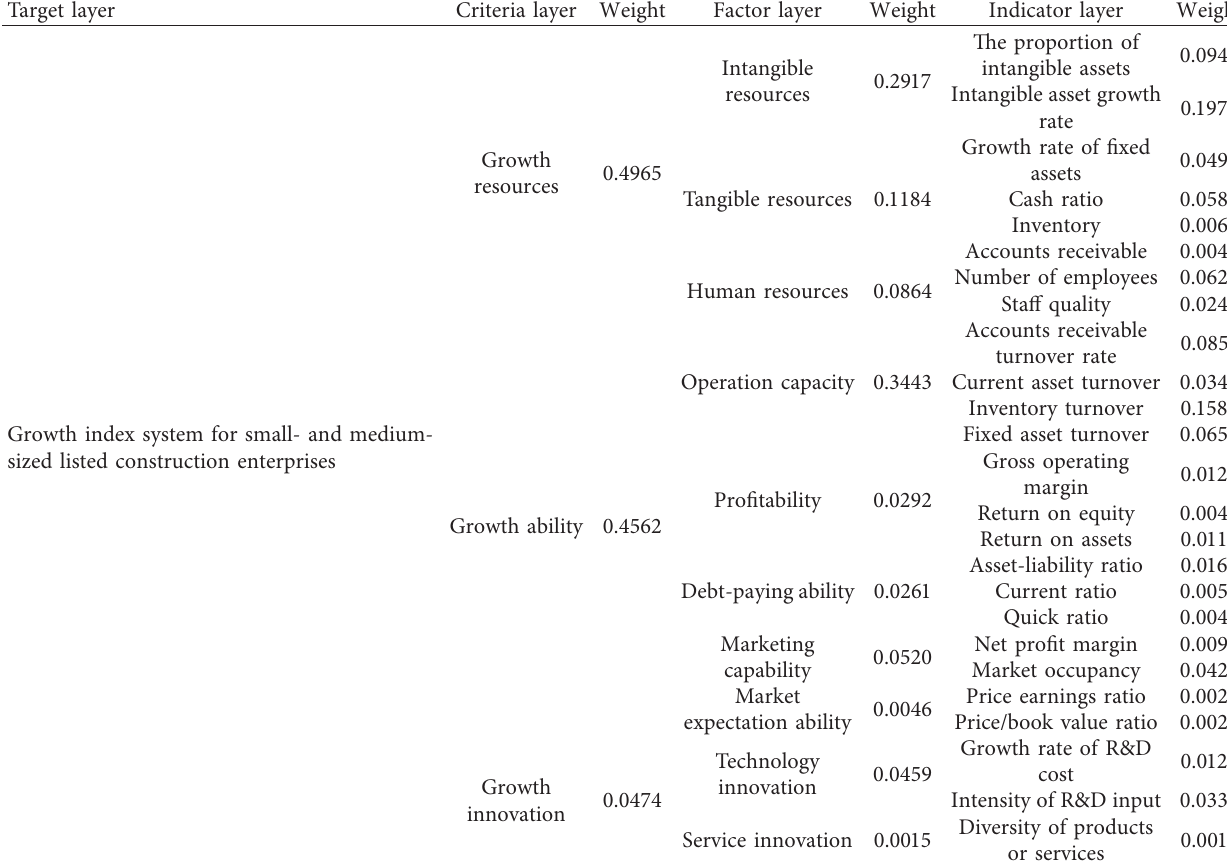
Table 3: Index weight of each level.